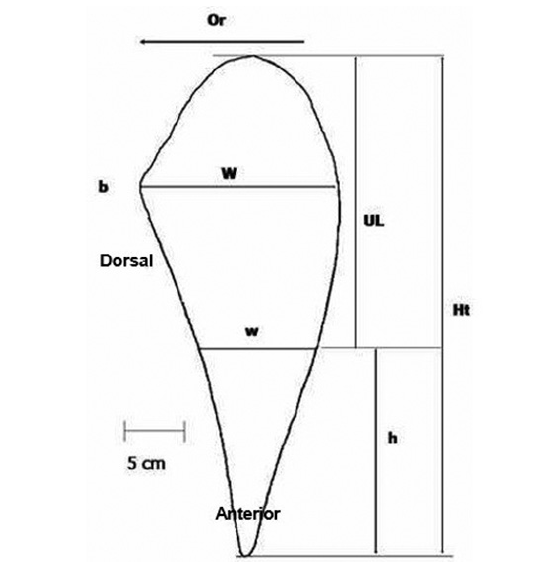
Figure 3. Measurements of interest to estimate the orientation and body-size of Pinna nobilis . In situ can be measured: W and w, maximum and minimum width respectively; UL, unburied length and Or, orientation of the gape. Maximum shell length (Ht) and length of the buried part (h) can be measured by removing the specimens from the bottom. Besides, Ht can be estimated by applying specific mathematical models (Garcia-March and Vicente